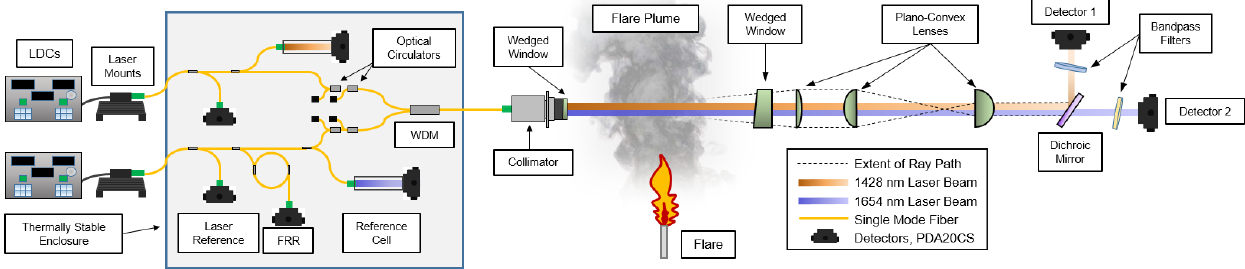
Figure 2. Schematic of the optical measurement system for measuring synchronous path-averaged BC and H 2 O volume fractions along a path through the flare plume. Components within the shaded box were temperature-stabilized within a thermo-electric heater–cooler. Dashed lines representing ray path extent show how optical arrangement minimizes any effects of beam steering through the